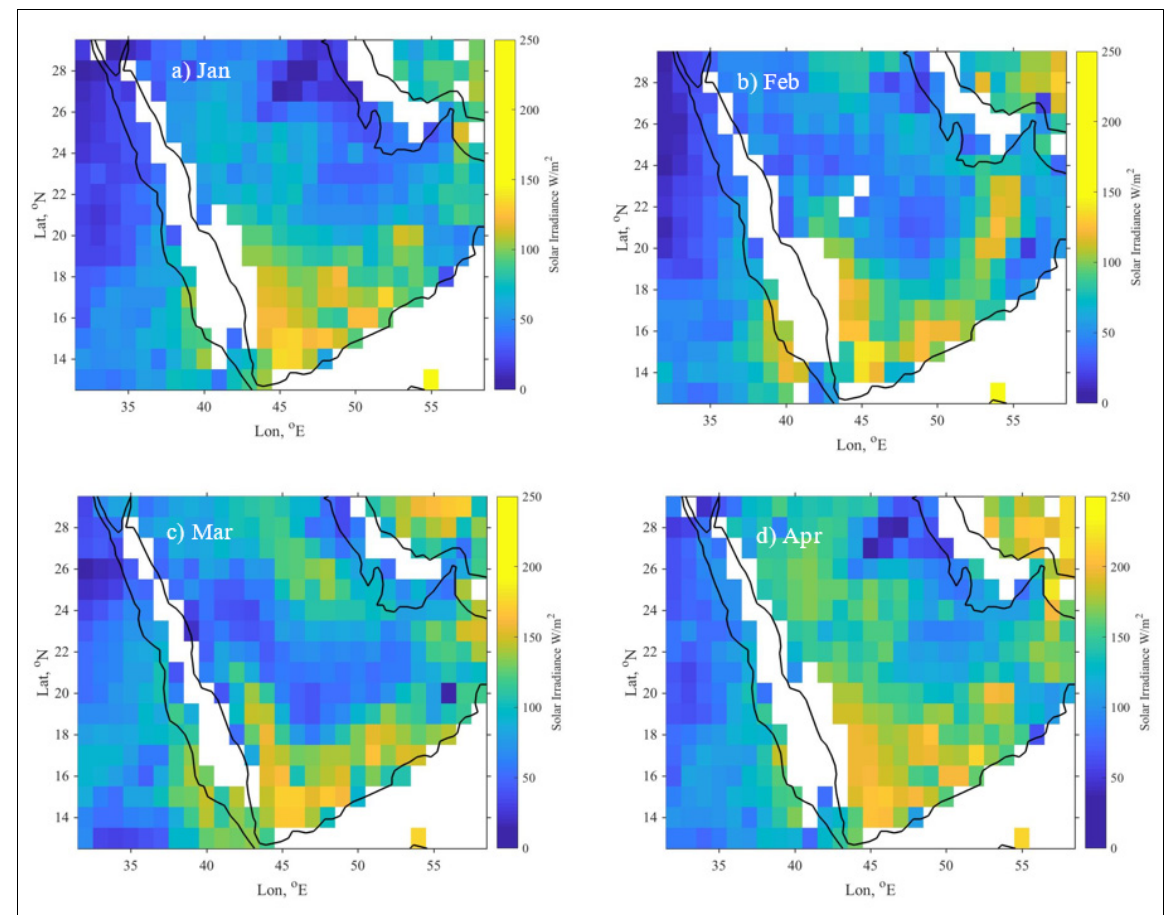
Figure 8. Intra-annual direct solar irradiance over AP during ( a – d ) January–April 2016, respectively.